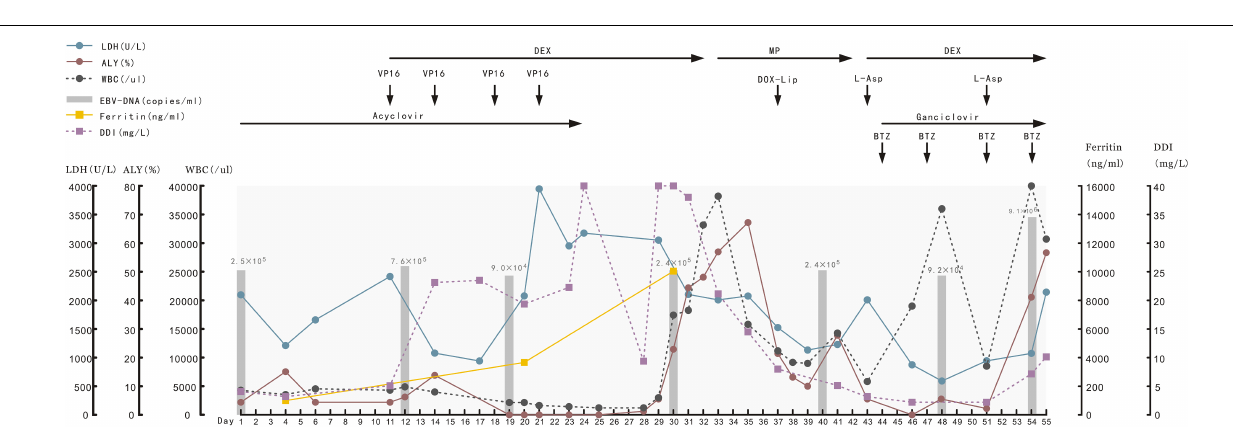
FIGURE 3 | Axial magnetic resonance imaging of the brain in this ANKL patient. Axial T2-weighted (1B–3B) and fluid-attenuated inversion recovery (1C–3C) of brain showing white matter high signal at bilateral centrum ovale, periventricular areas, basal ganglia areas and pontine. Axial T1-weighted (2A) imaging and diffusion-weighted imaging (2D) shows high signal at areas of putamen and caudate nucleus head.